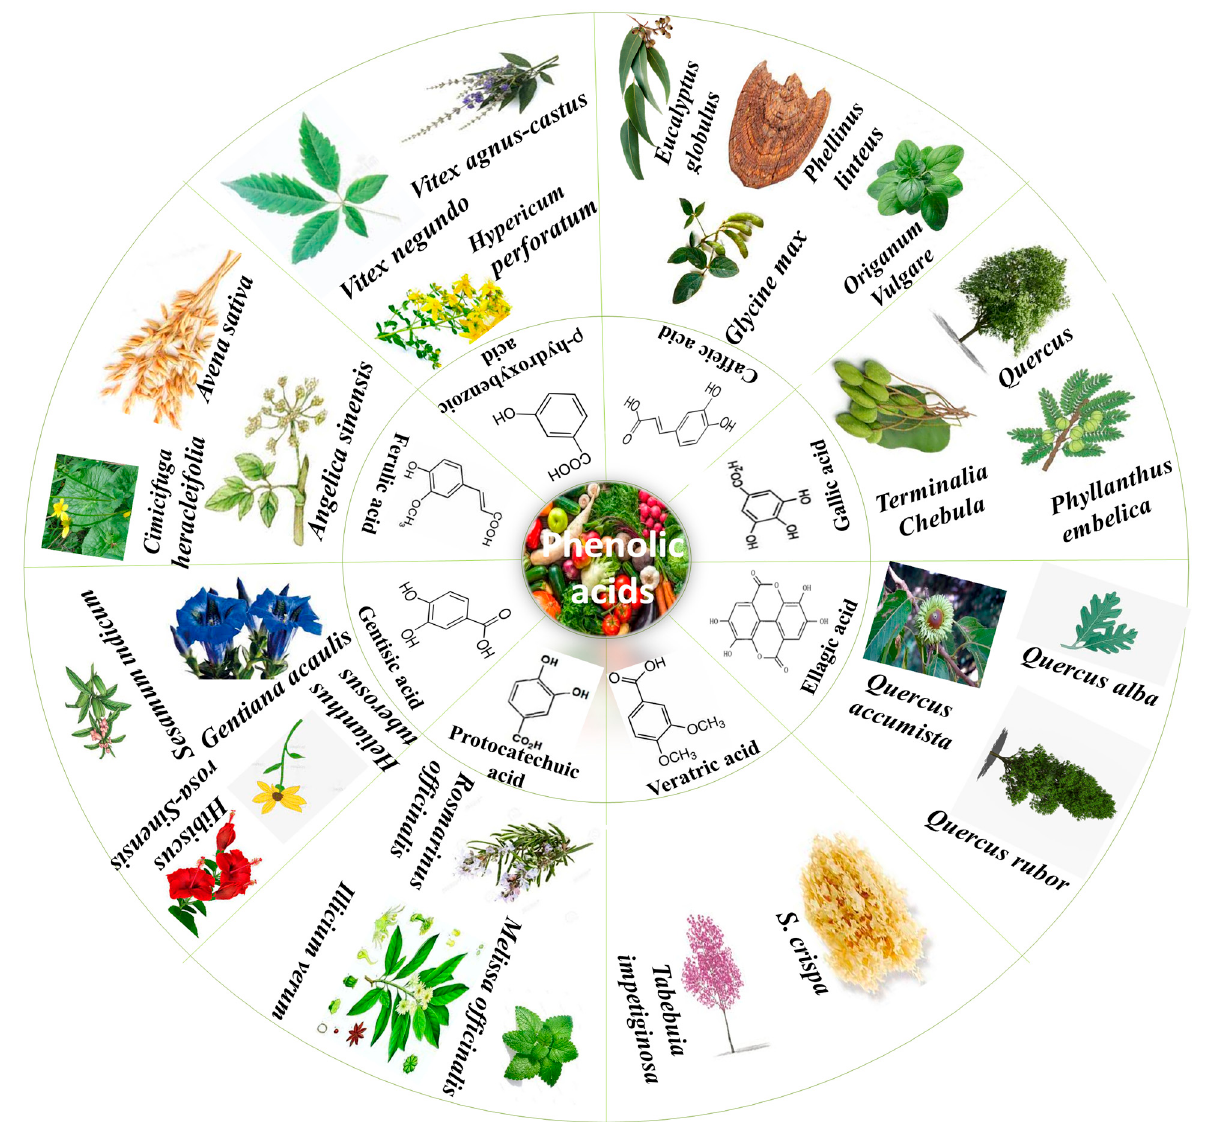
Figure 1. Phenolic acids and their plant sources.